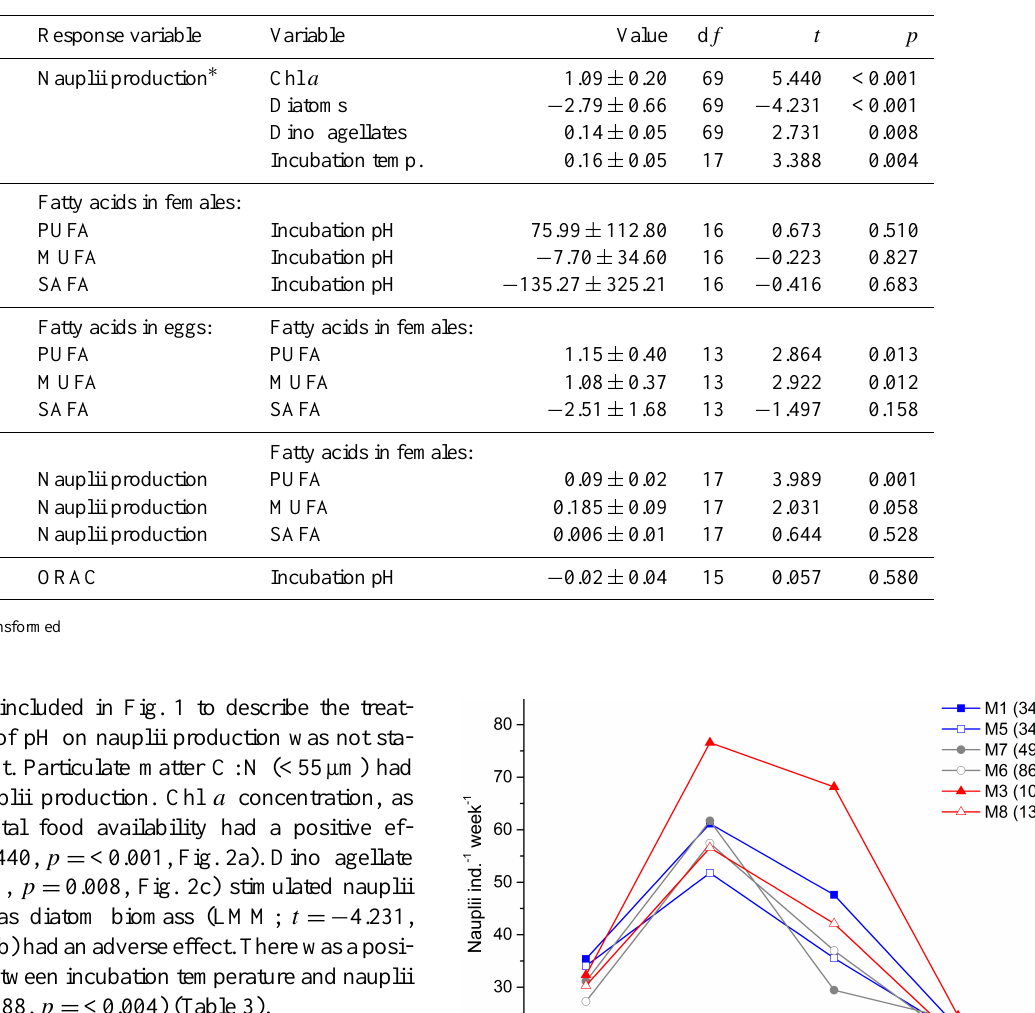
Table 3. T -statistics of the retained fixed effects in the LMM.